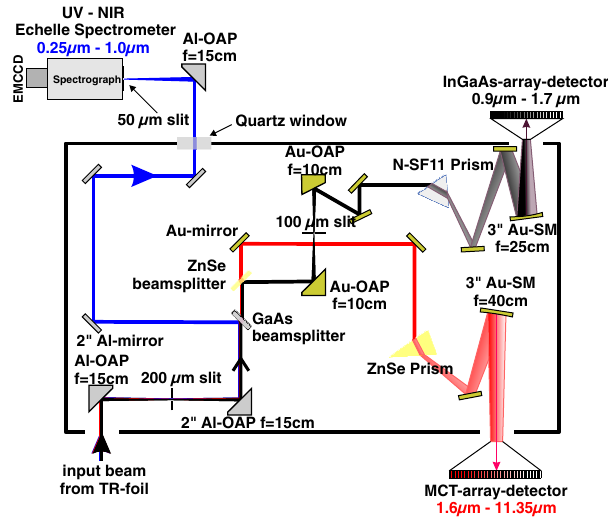
FIG. 2. Overview of the main components of the TR spec- trometer showing a schematic top-view of the spectrometer design and highlighting the three main light paths. The vacuum chamber dimensions are 120 cm × 68 cm × 40 cm. Additional optical elements such as polarizers, attenuators and bandpass filters, as well as imaging optics for monitoring the TR beam pointing used during the calibration and TR measurement are not shown here for clarity. Elements that have to be aligned during calibration or experimental runs are